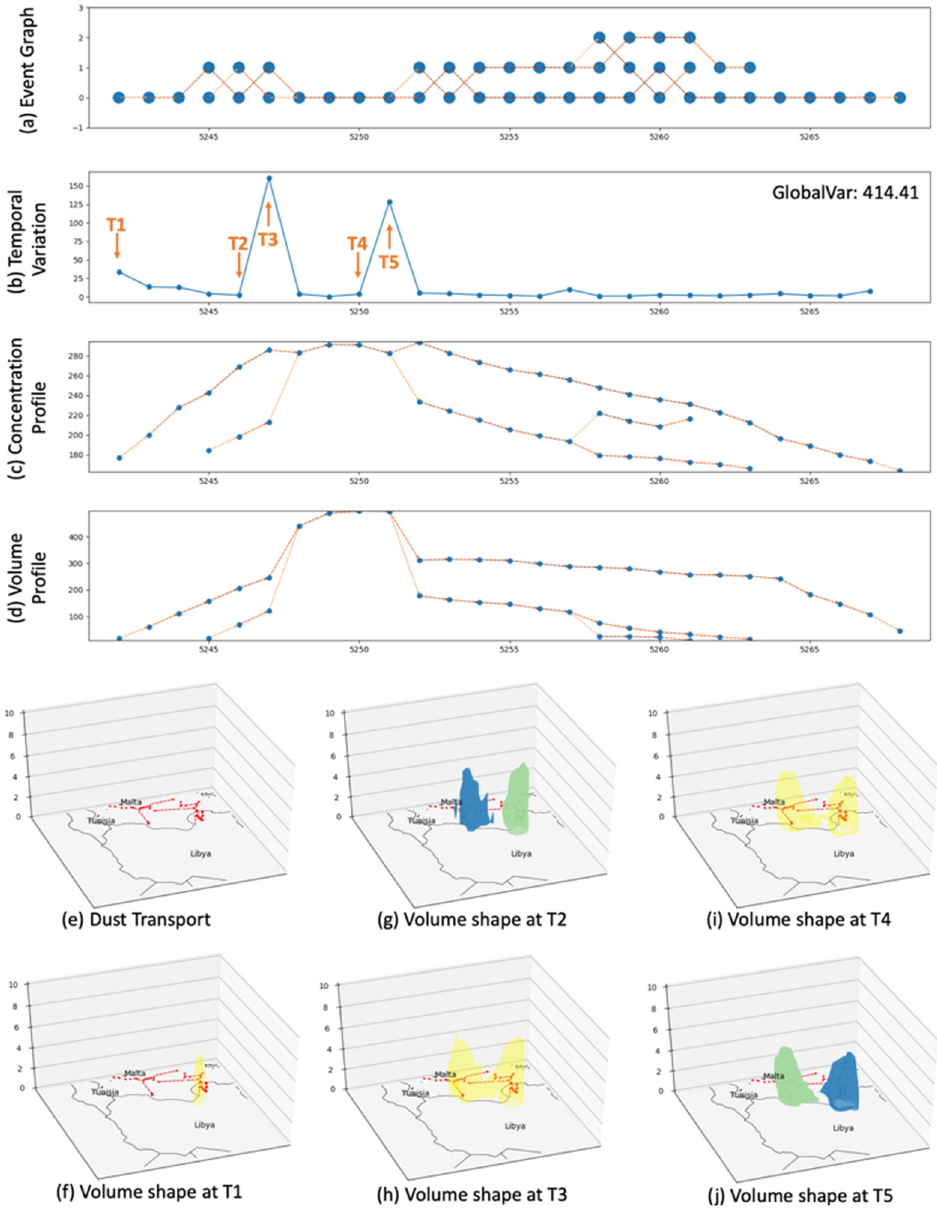
Figure 9. Event graph and temporal variation of the September 2014 Libya dust event. The third event graph represents the Middle East dust event in September 2014, where a long-term dust storm with high dust concentration and volume. It combined the characteristics of a haboob and a shamal. A haboob is usually a short-lived but dramatic dust event appearing in a wall of dust sweeping across the ground, while a shamal is a pattern of persistent northwesterly winds in the Middle East region. When dust events are associated with shamal, they can persist over a wide spatial and temporal range. This specific event is not recorded in NASA Earth Observatory, but a similar one was recorded in the same time of 2015 (https: // earthobservatory.nasa.gov / images / 86539 / dust-marches-across-iraq-and-iran). The event represented in Figure 10 demonstrates that this event last for 23 days and has the one of the highest GlobalVar values (within the experiment data) of 12784.68. The characteristics of a haboob in this event can be reflected in Figure 10(b1–b4), where dust has a relatively low concentration but a large volume. One of the first peaks in variation is highlighted as T1, where a high wall of dust splits into two objects with almost even volume. Similarly, from the highlighted time T2, it is observed